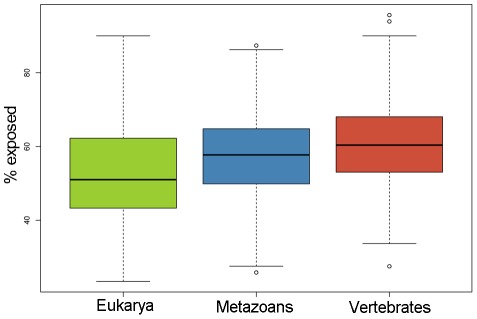
Percentage of residues exposed in PDB structures classified in 3 age groups: Eukarya, Metazoans and Vertebrates.Wilcoxon tests were performed to assess the significance of the difference: Eukarya vs Metazoans: p-value<2.2e−16 , Eukarya vs Vertebrate: p-value<2.2e−16 , Metazoans vs Vertebrates: p-value = 0.0005 ).